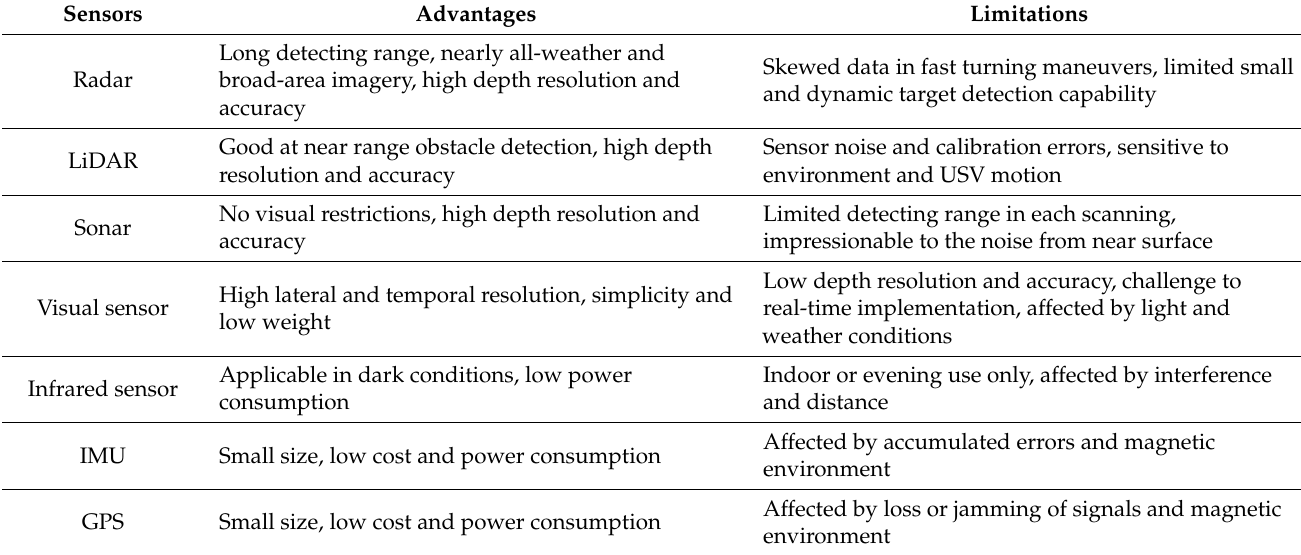
Table 5. Characteristics of USV sensors